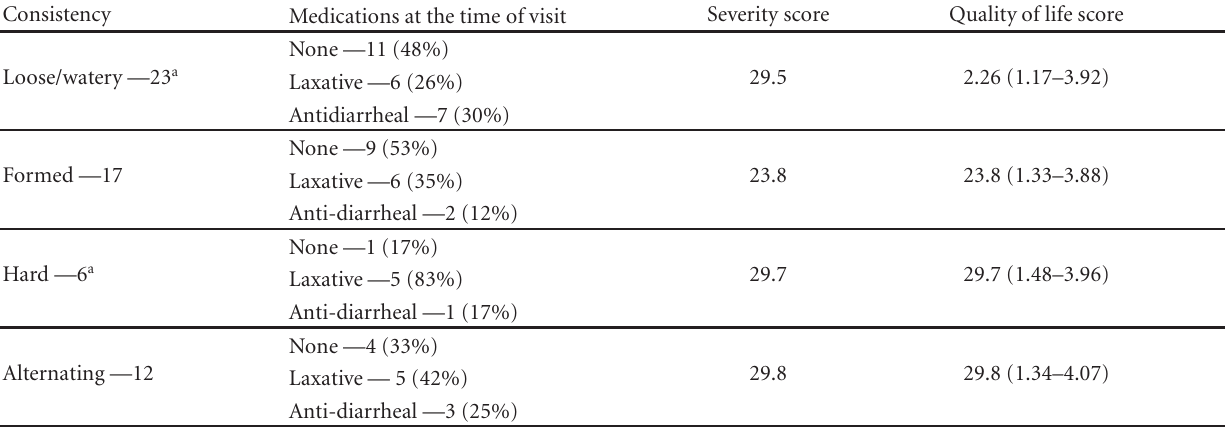
Table 2: Stool consistency, medication use, severity, and quality of life scores.